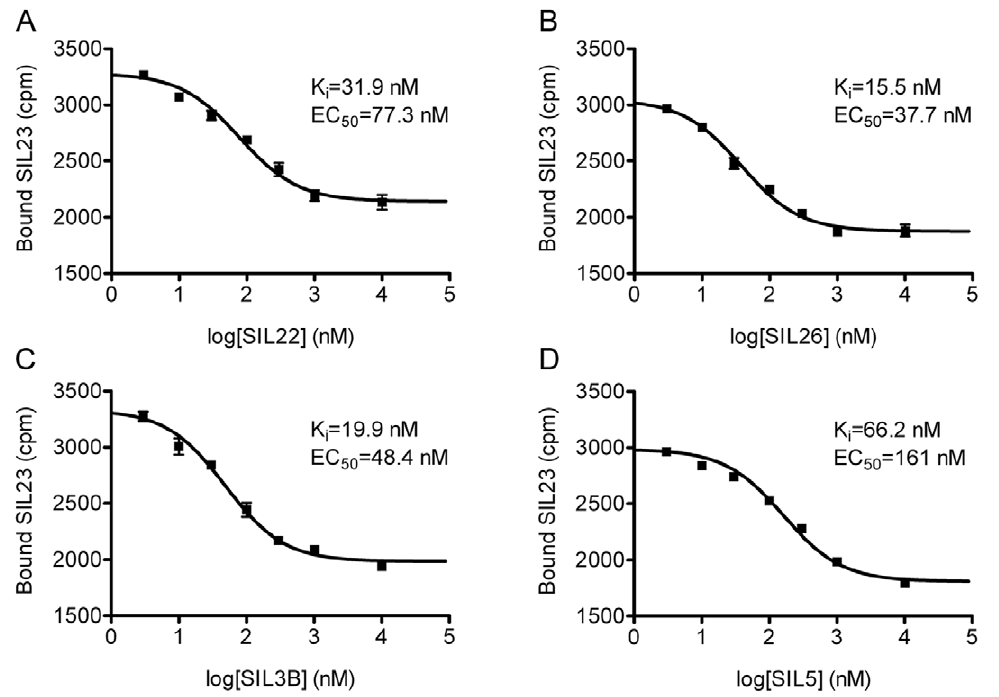
Figure 3. SIL23 competitive binding assays demonstrate higher affinity binding to recombinant a -syn fibrils for additional phenothiazine analogues, indicating that the structure of this compound class can be optimized to improve binding affinity using SIL23 assays. a -Syn fibrils were incubated with 200 nM [ 125 I]SIL23 and increasing concentrations of SIL22 ( A ), SIL26 ( B ), SIL3B ( C ), and SIL5 ( D ). The amount of bound radioligand is plotted as a function of the concentration of unlabeled competitor ligand in the incubation mixture. Data points represent mean + / 2 s.d. (n=3). EC 50 values were determined by fitting the data to the equation Y=bottom + (top-bottom)/(1 + 10 (x-logEC50) ). Similar results were obtained in two independent experiments.